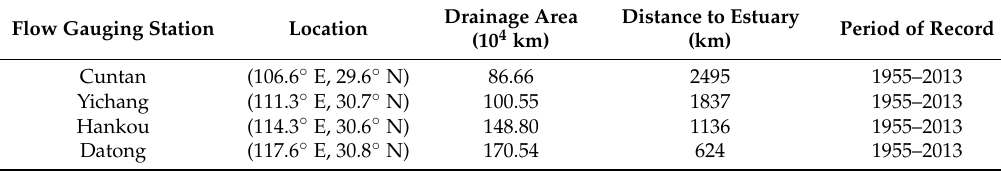
Table 1. Flow gauging stations at the main stem of the Yangtze River.